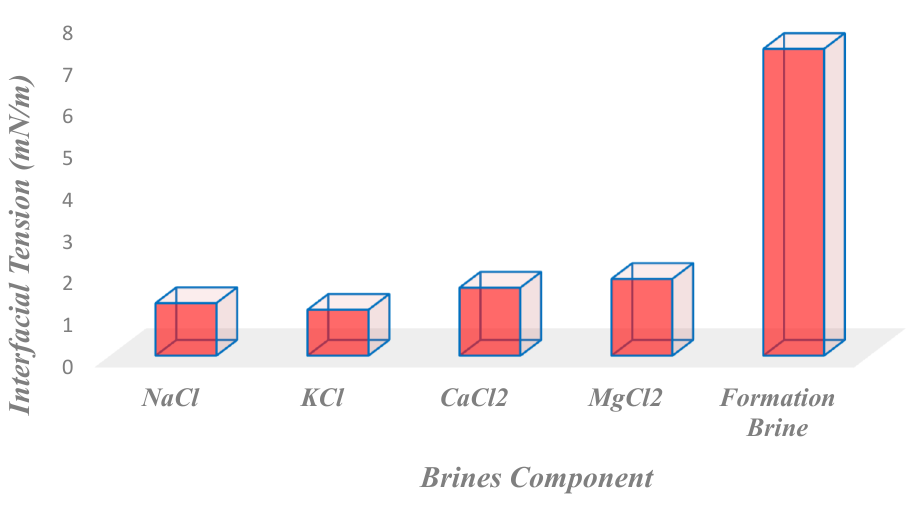
Figure 2. Interfacial tension measurement for different brine components.